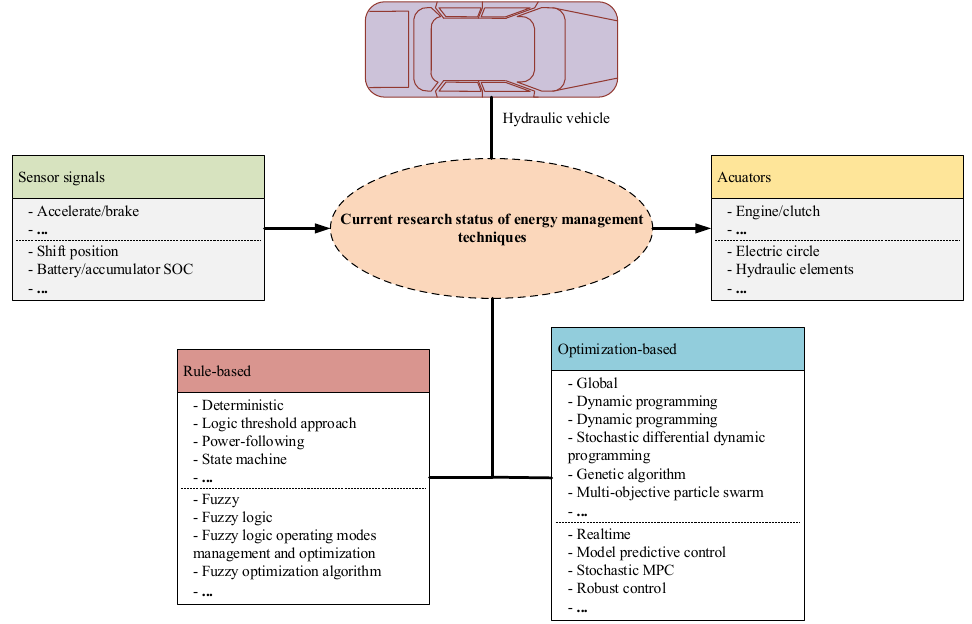
Figure 20. Control strategy classification of hydraulic hybrid vehicle.